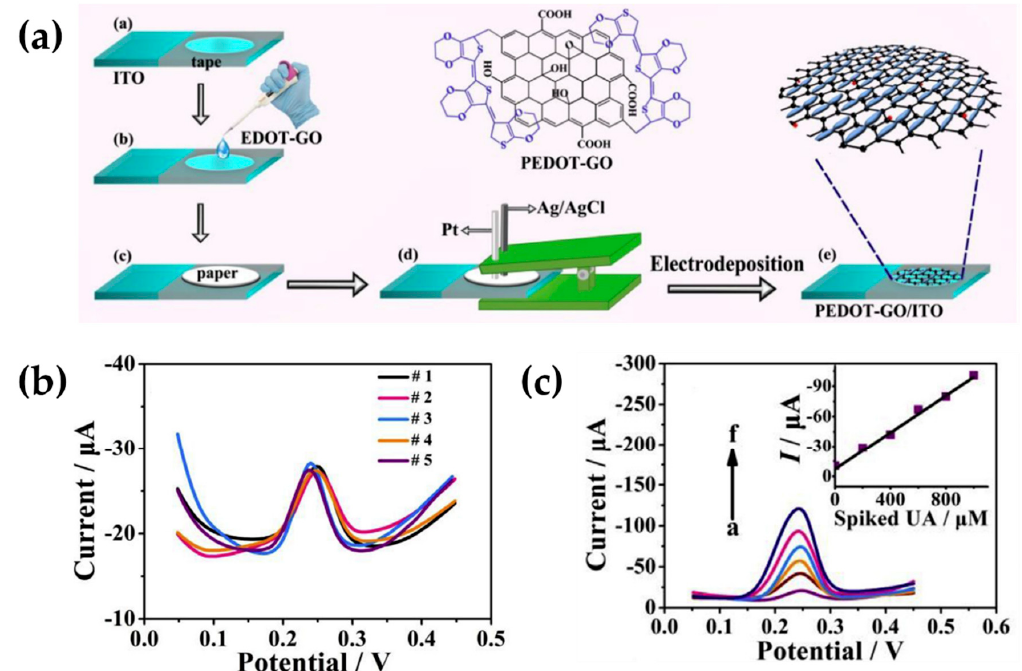
Figure 5. ( a ) Schematic route for the preparation of the integrated paper-based analytical device; ( b ) differential pulse voltammetry (DPV) response of the saliva sample using 5 disposable electrodes fabricated independently and ( c ) electrochemical response of saliva samples spiked with increasing concentrations of uric acid in 200 mM increments (inset calibration plot). Adapted with permission from reference [83]. Copyright © 2019 Elsevier B.V. Molecules 2020 , 25 , x 13 of 39